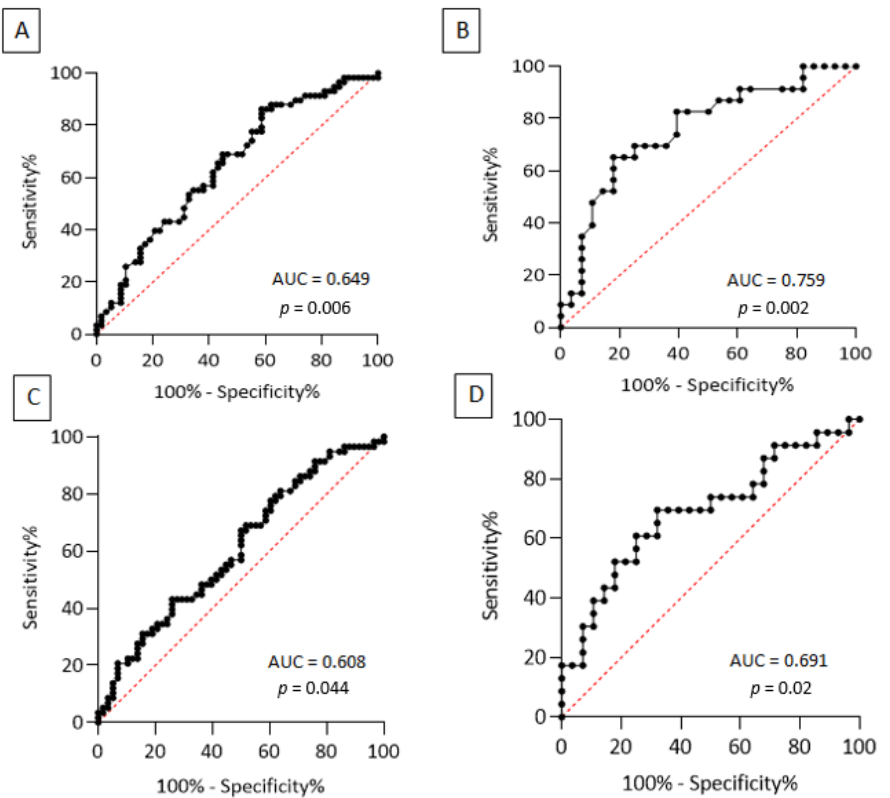
Figure 1. ROC curve of lymphocyte count to discriminate PD patients from HC (panel ( A )) and PD-MCI from PD-NC (panel ( B )); ROC curve of NLR values to discriminate PD patients from HC (panel ( C )) and PD-MCI from PD-NC (panel ( D